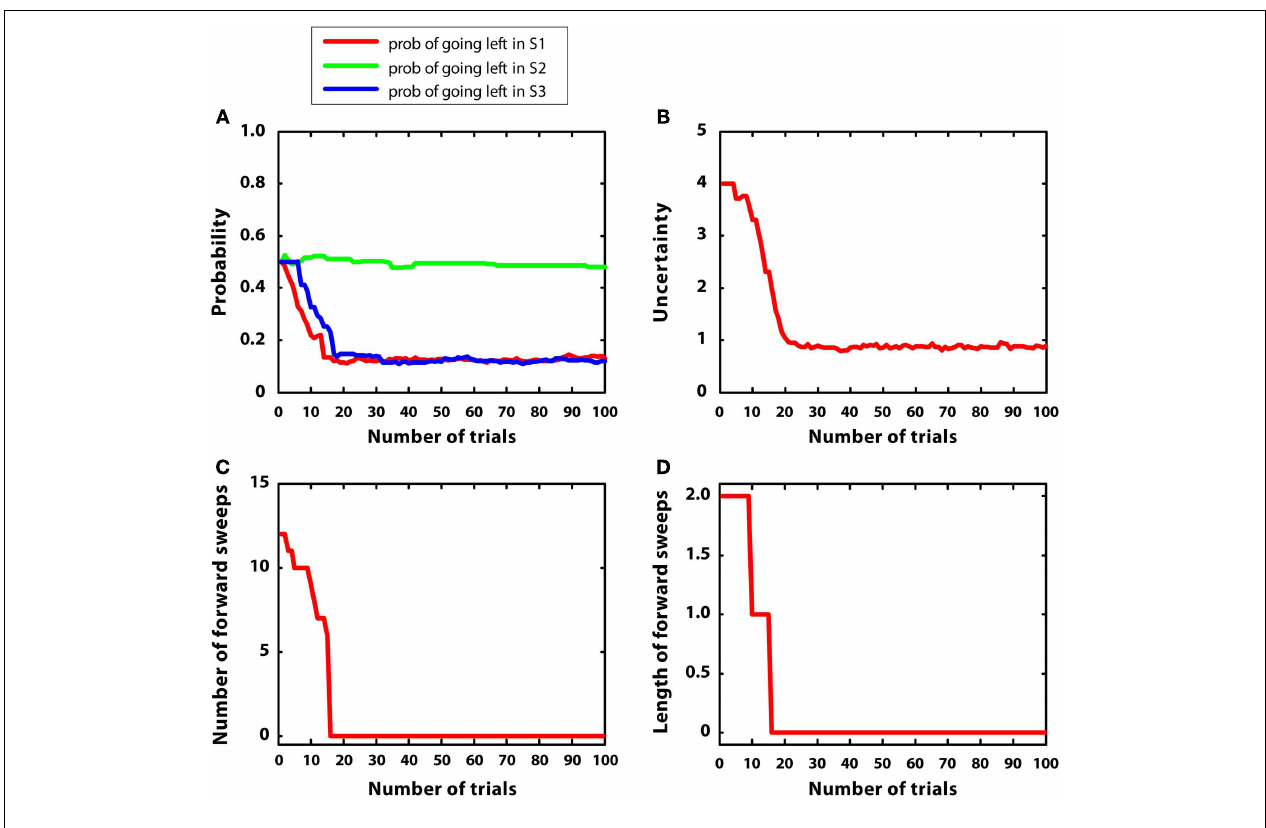
Shows the number of forward sweeps (associated to mental simulation) used for the choice at S1; zero means that mental simulation is not used. (D) (bottom right) Shows the length of forward sweeps used for the choice at